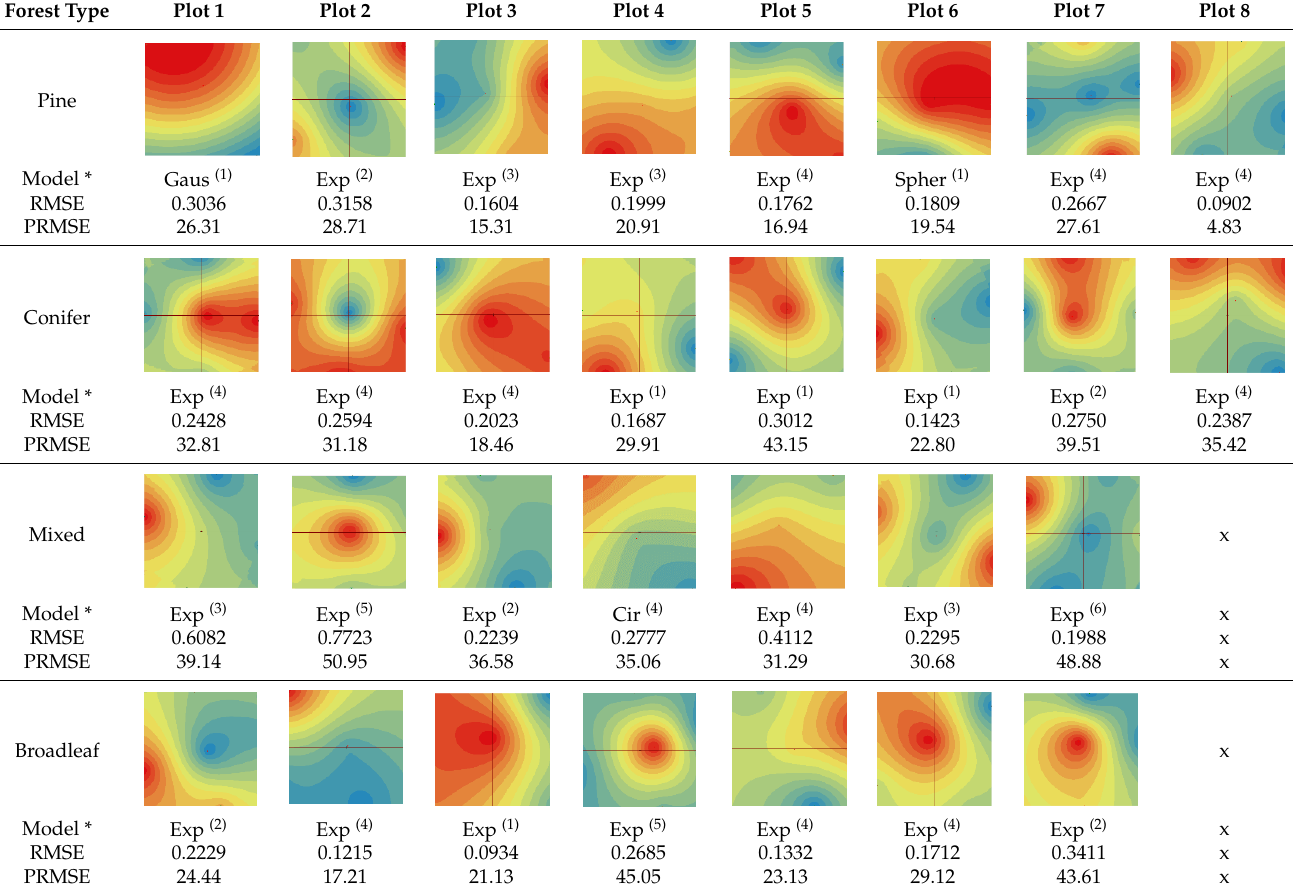
Table 1. The ordinary cokriging method-derived maps of 1-m cell fine surface fuel loads (fSFL) and for the inventory plots of forest types.